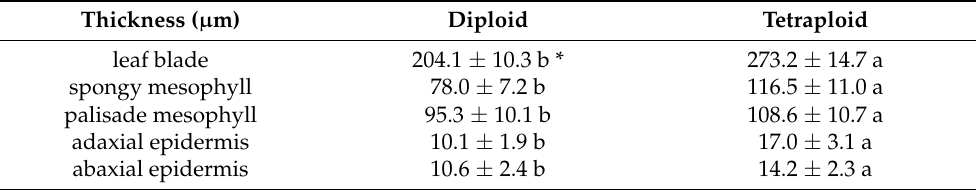
Table 4. Anatomical structure of the leaves of diploid and tetraploid clone 4x-25 of the apple cv. ‘Redchief’.